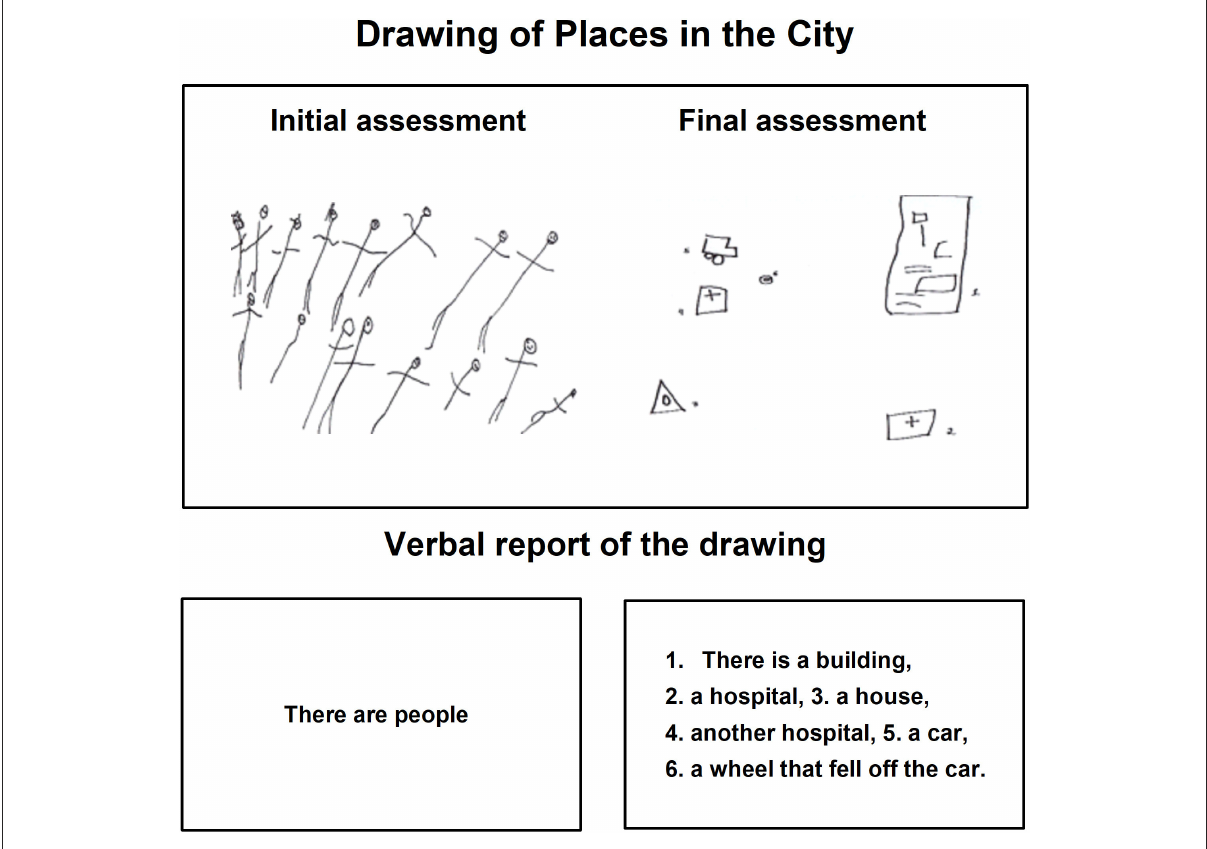
FIGURE9 Child I drawing of places in the city during the initial and final